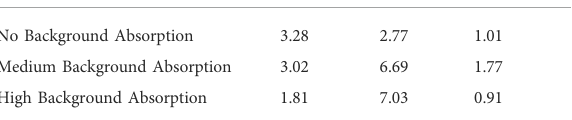
TABLE 3 Unmixing processing time of the BSS algorithms (PCA, ICA, andNNMF)todistinguishthesourcecomponentsfromthevessel- mimicking phantoms with different background